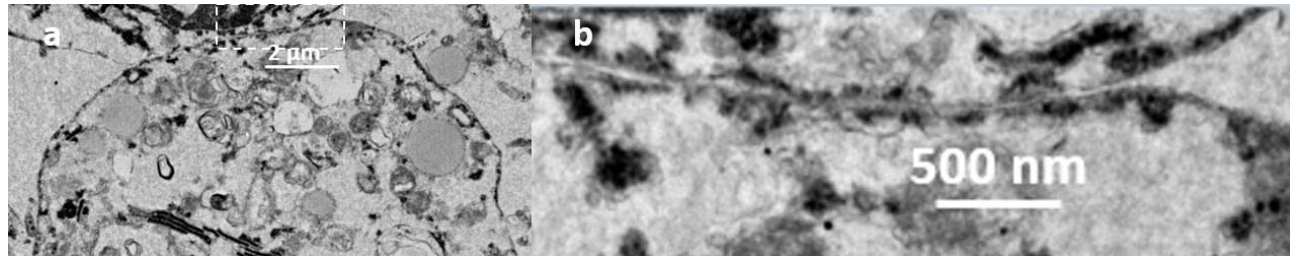
Figure 12. TEM of BmVIII ‐ SCC cell at day 85 p.i. exhibiting budding of cellular material (exocytosis) from the plasma membrane. Rough endoplasmic reticulum (RER) is visible as organized strands. A large endosome (ENDO) is visible, with a smaller endosome located near the site of exocytosis.